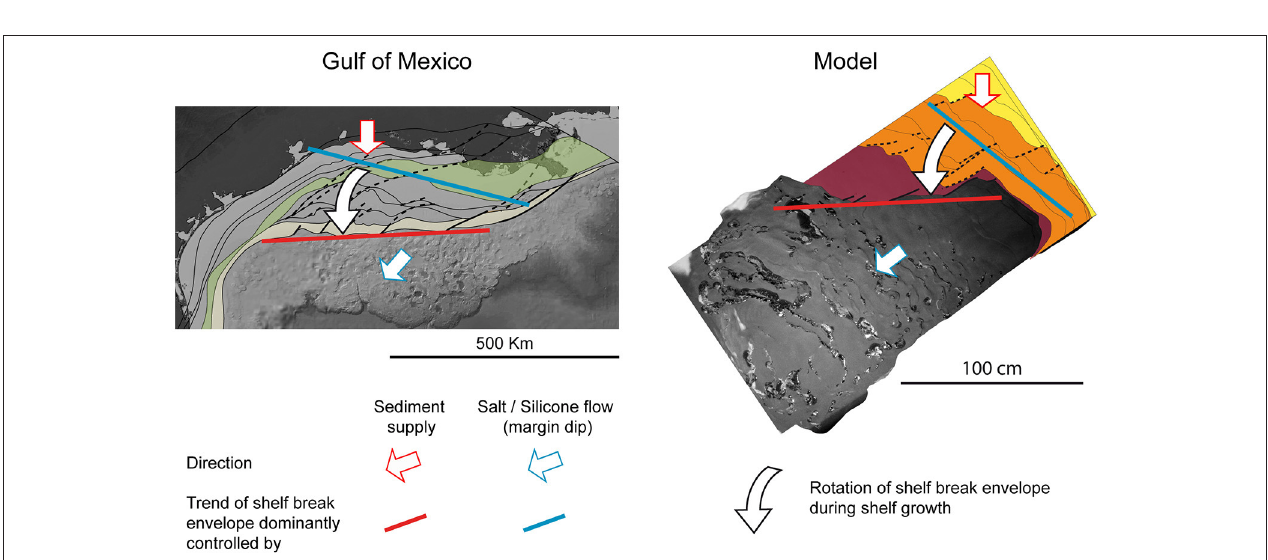
FIGURE 9 | Comparison between the offset (i) of an oceanic spreading ridge by a transform fault (left) and (ii) of a shelf break by a transfer zone in salt tectonics (right) .